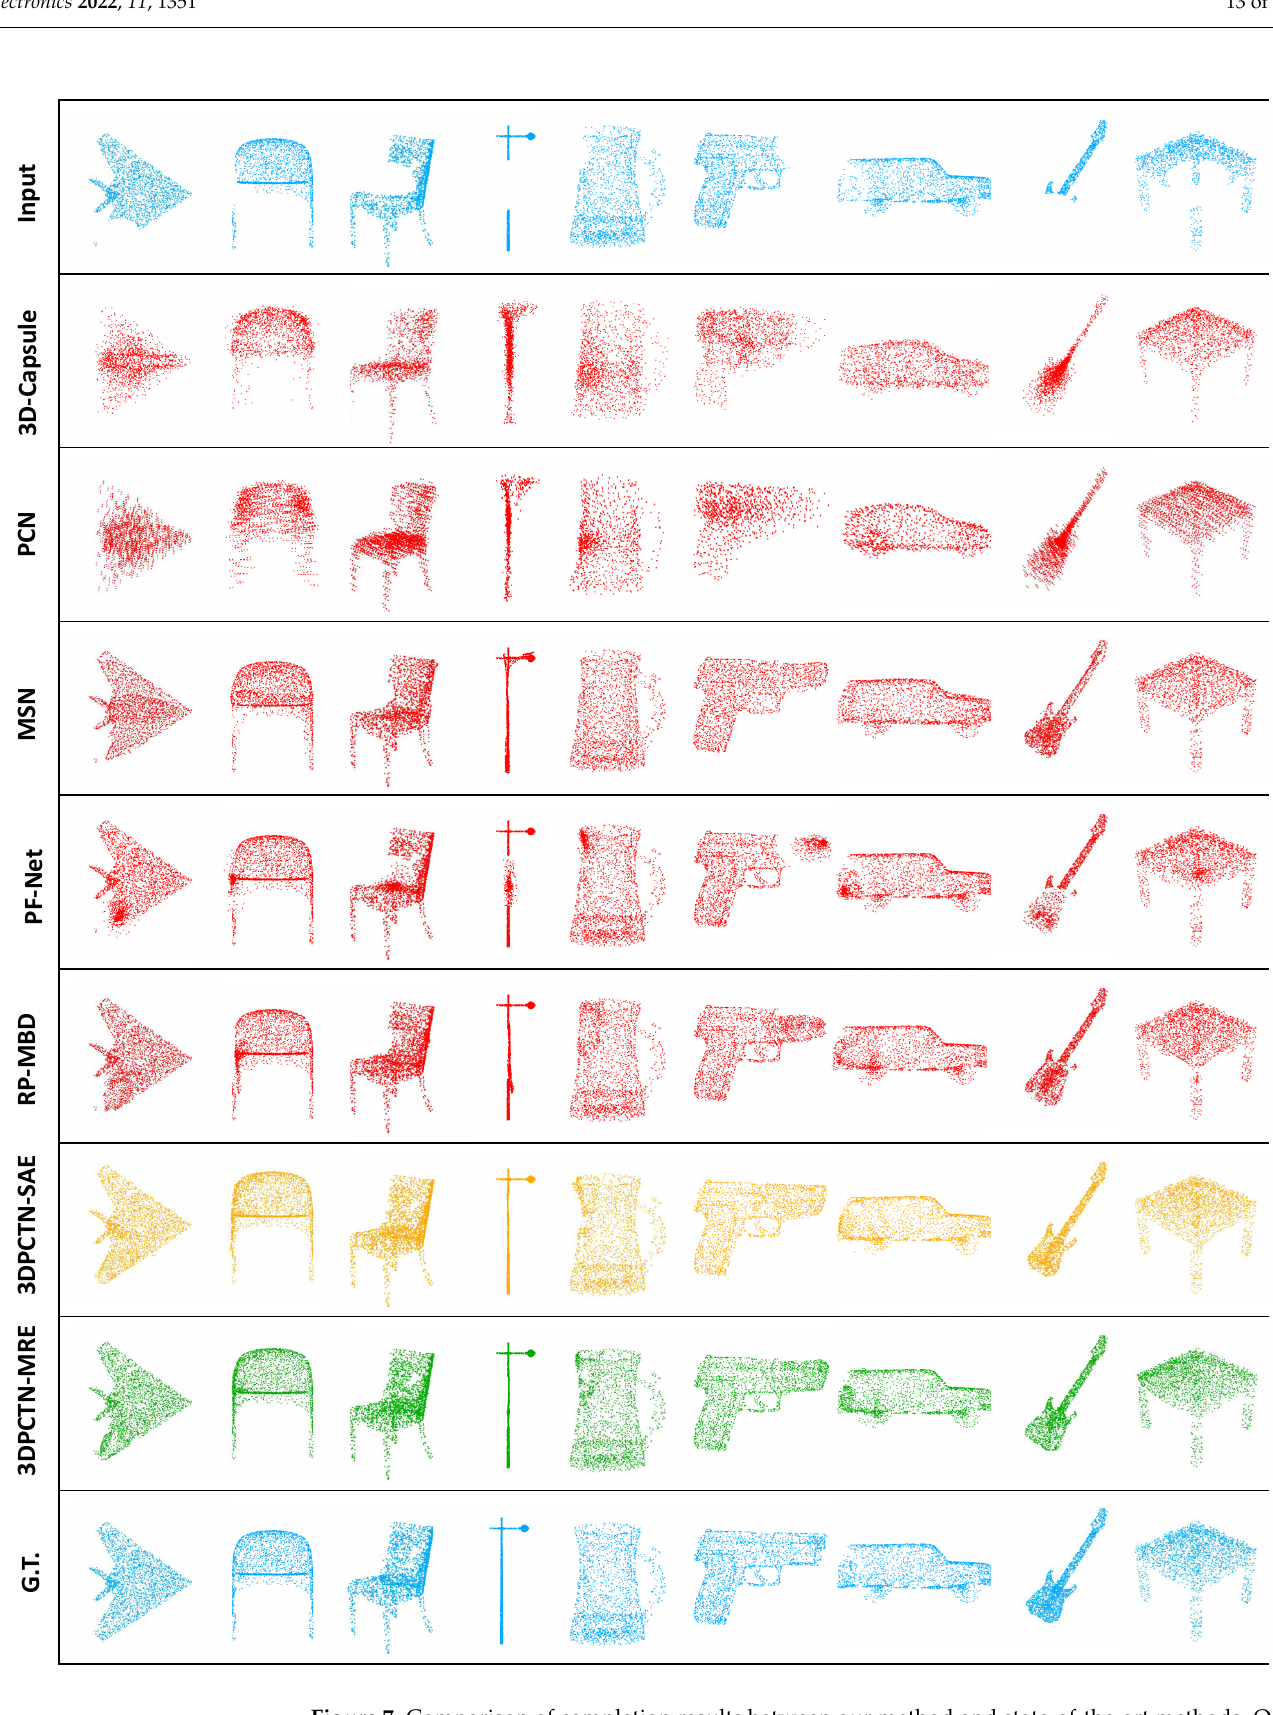
Figure 7. Comparison of completion results between our method and state-of-the-art methods. Our 3DPCTN (3DPCTN-SAE and 3DPCTN-MRE) successfully predicts the missing part and integrates it to produce a good